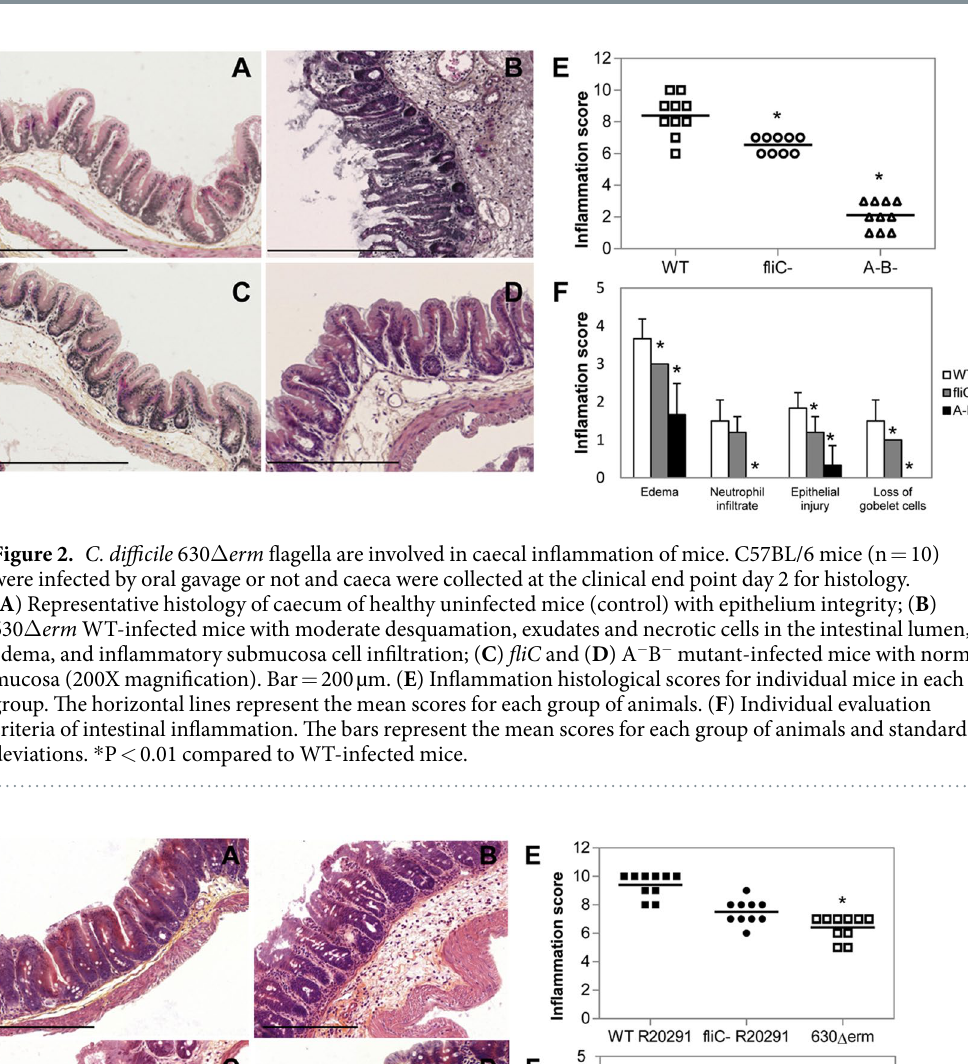
strong NF- κ B activation was observed in caeca of the motB mutant-infected mice compared to the negative control (Fig. 4A). We also analyzed the ERK1/2 and JNK MAPKs activation in the intestine of mice. Significant increase of ERK1/2 (1.5 fold) and JNK (2.5 fold) phosphorylation was observed in the R20291 WT- and motB mutant-infected mice compared to the negative control (Supplementary Fig. S3A,B). A similar level of ERK1/2 and JNK activation was also observed in the caecum of the fliC mutant, but not in the non-toxigenic A − B − mutant-infected animals (Supplementary Fig. S3A,B), suggesting a probable action of toxins which are known to also activate MAPKs in intestinal cells 22 . In accordance to the lesser degree of caecal inflammation observed in the 630 Δ erm WT-infected mice, a weak but significant activation of NF- κ B, ERK1/2 and JNK, in caecal tissue of these animals (Fig. 4B and